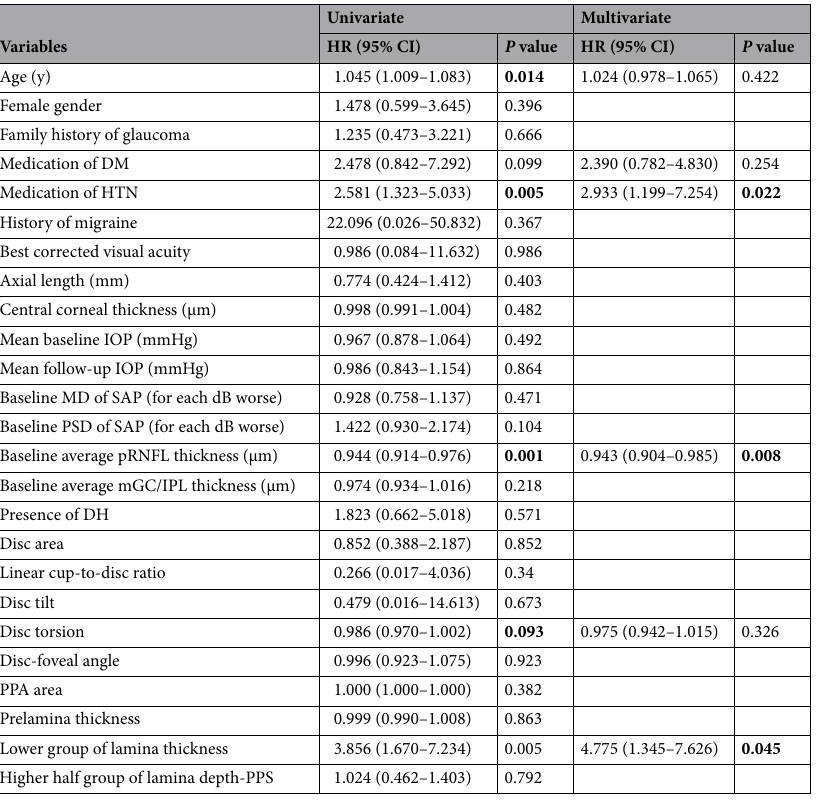
Table 6. Factors associated with progression to NTG in NTG suspect patients without myopia. HR, hazard ratio; CI, confidence interval; DM, diabetes mellitus; HTN, systemic hypertension; pRNFL, peripapillary retinal nerve fiber layer; mGC-IPL, macular ganglion cell-inner plexiform layer; IOP, intraocular pressure; MD, mean deviation; PSD, pattern standard deviation; dB, decibel; MD, mean deviation; SAP, standard automated perimetry; DH, disc hemorrhage; PPA, peripapillary atrophy; PPS, peripapillary sclera. Factors with P < 0.1 in univariate analysis were included in multivariate analysis. Data are mean ± standard deviation unless otherwise indicated. Factors with statistical significance are shown in